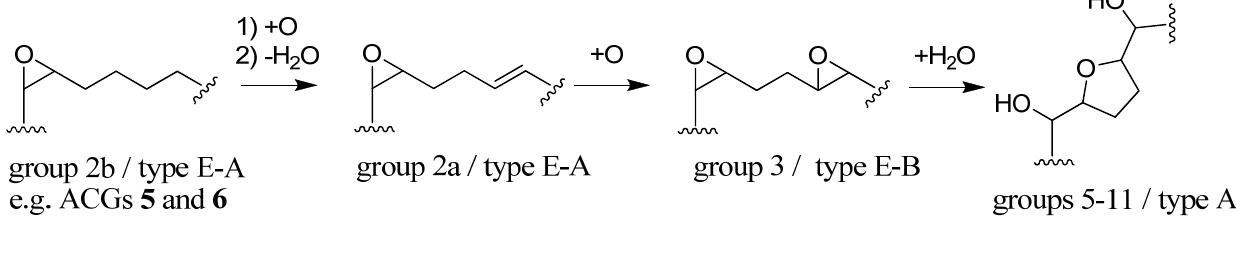
Figure 5. Putative pathway from group 2b to type A